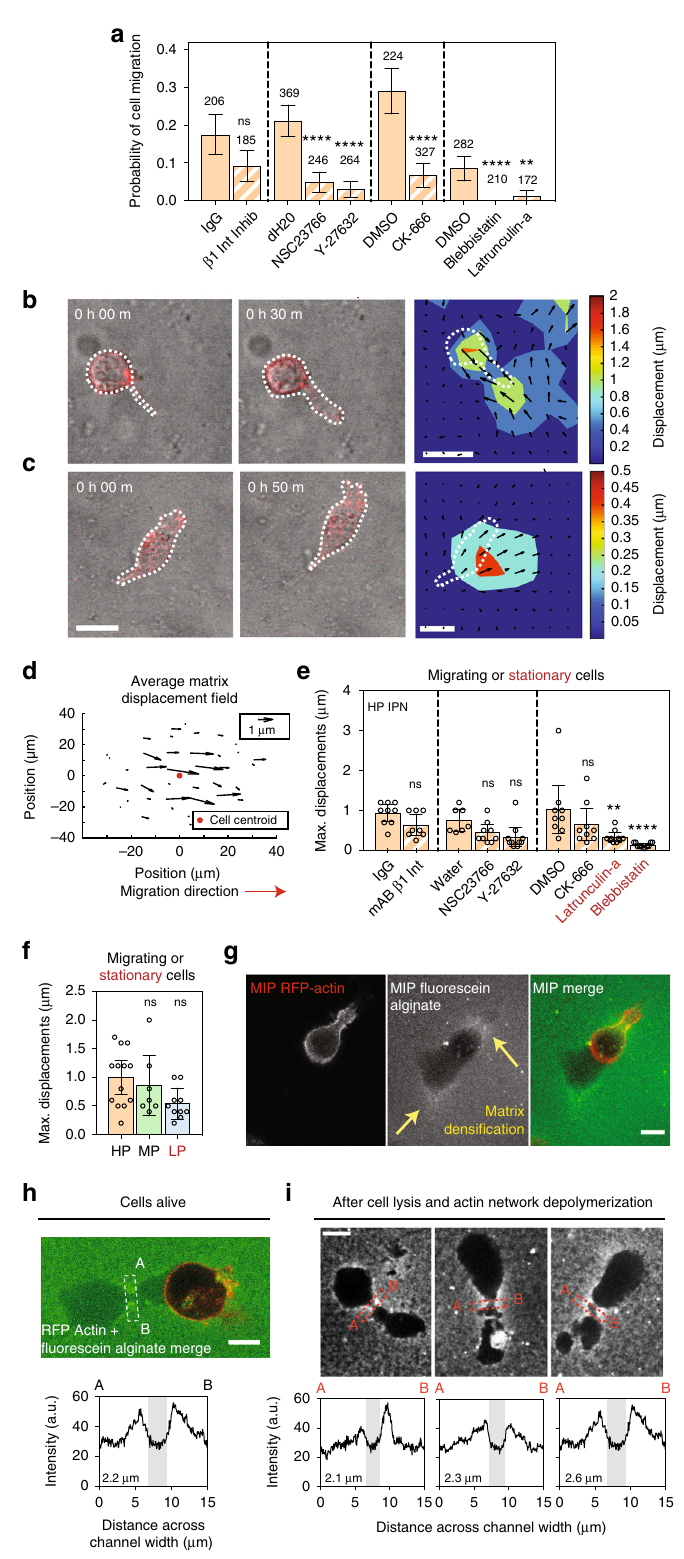
normalized strain rate of 0.5 mmmin − 1 , were applied while the plug was submerged in serum-free RPMI. For human tumor tissue testing, a 4mm indenter was used to apply repeated indentations that were held for 1 h and allowed to recover for 1 h. For MDA-MB-231 tumor tissue testing, a 1.5mm indenter was used to apply repeated indentations that were held for 1 h and allowed to recover for 2h. Because the initial point of contact could be dif fi cult to determine from force vs. indentation curves for the tissue plug, indentation depth at 25% of